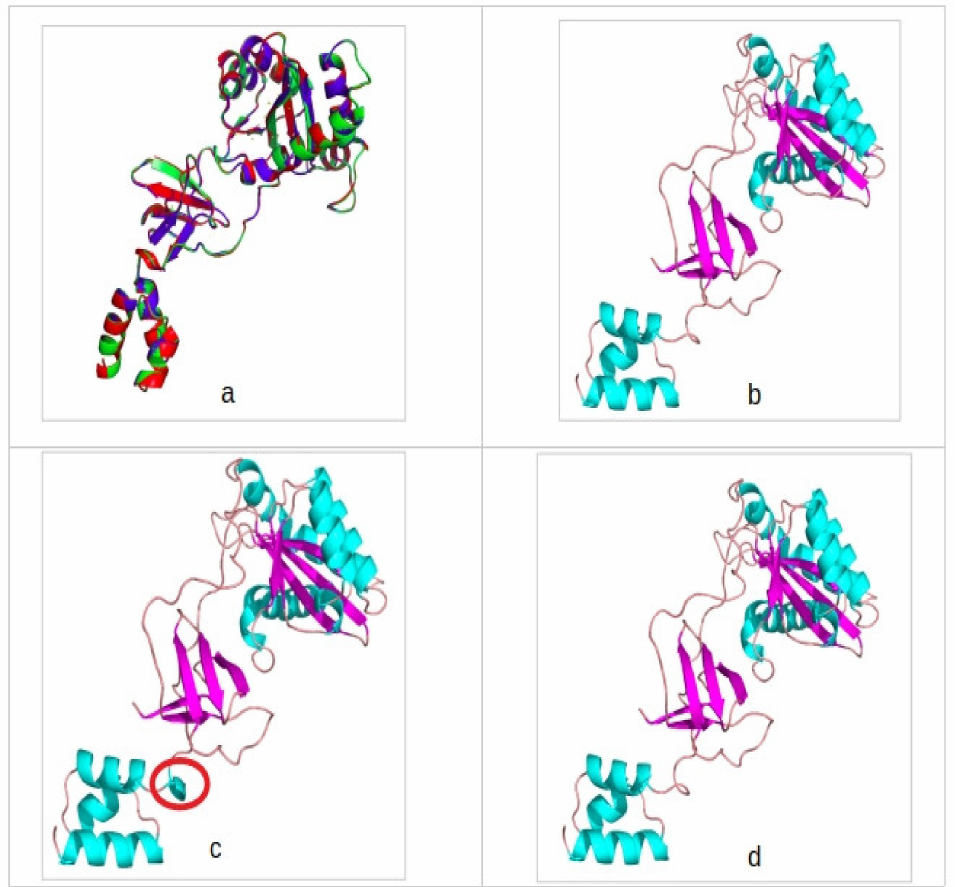
Figure 2. ( a ) A superimposition of all three integrase models showing high backbone identity and secondary structure conservation. ( b ) CRF02_AG integrase (IN) model colored according to secondary structure and in cartoon depiction. ( c ) Subtype B IN model colored according to secondary structure and in cartoon depiction. ( d ) Subtype C IN model colored according to secondary structure and in cartoon depiction. Encircled in red is the secondary structure di ff erence observed between the template structure and the generated IN models. Light blue indicates the helices, purple indicates beta-sheets, and tint color indicates